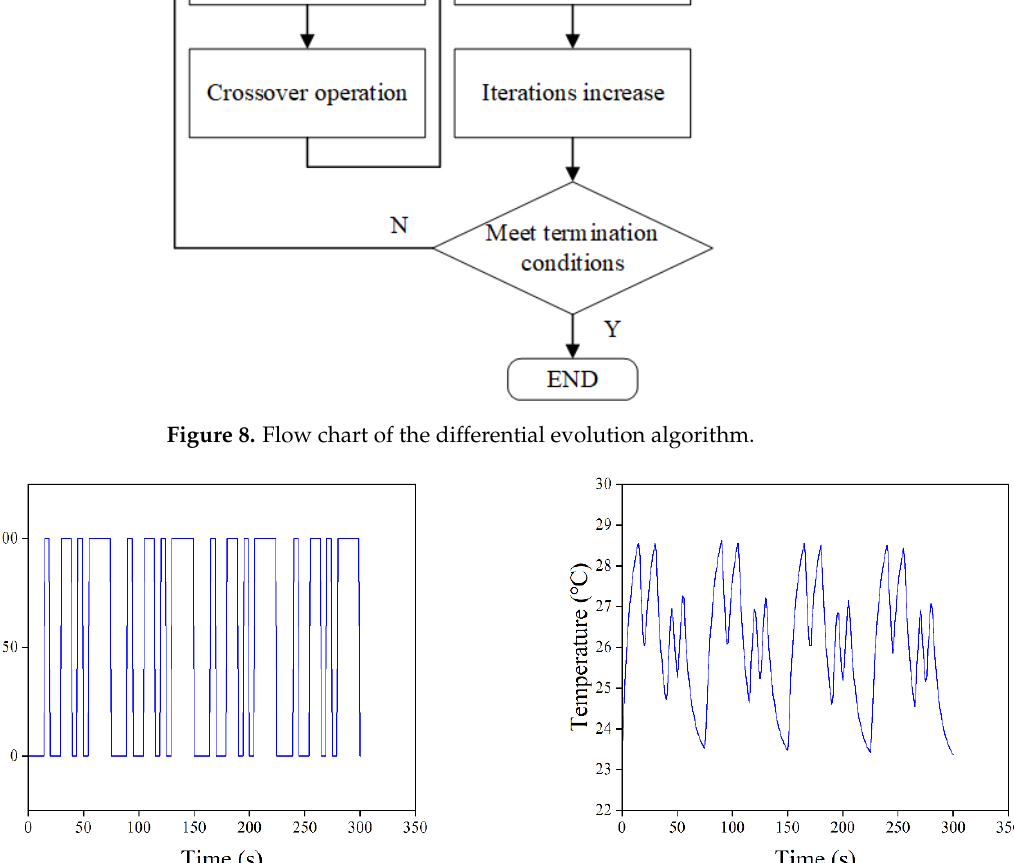
Figure 10. Identification results of the DE algorithm. ( a ) Change curve in the value of the fitness function. ( b ) Comparison curves of the identification results with the original data. Based on the excitation signal, the corresponding system response was calculated using the obtained transfer function, and compared with the original data collected from the temperature control system. As shown in Figure 10b, the calculated values of the sys- tem response fit well with the collected raw data, indicating that the system functions obtained from the model identification scheme based on the M sequence and DE algo- rithms had a high degree of accuracy, and that it could be used for subsequent optimiza- tion of the control algorithm.